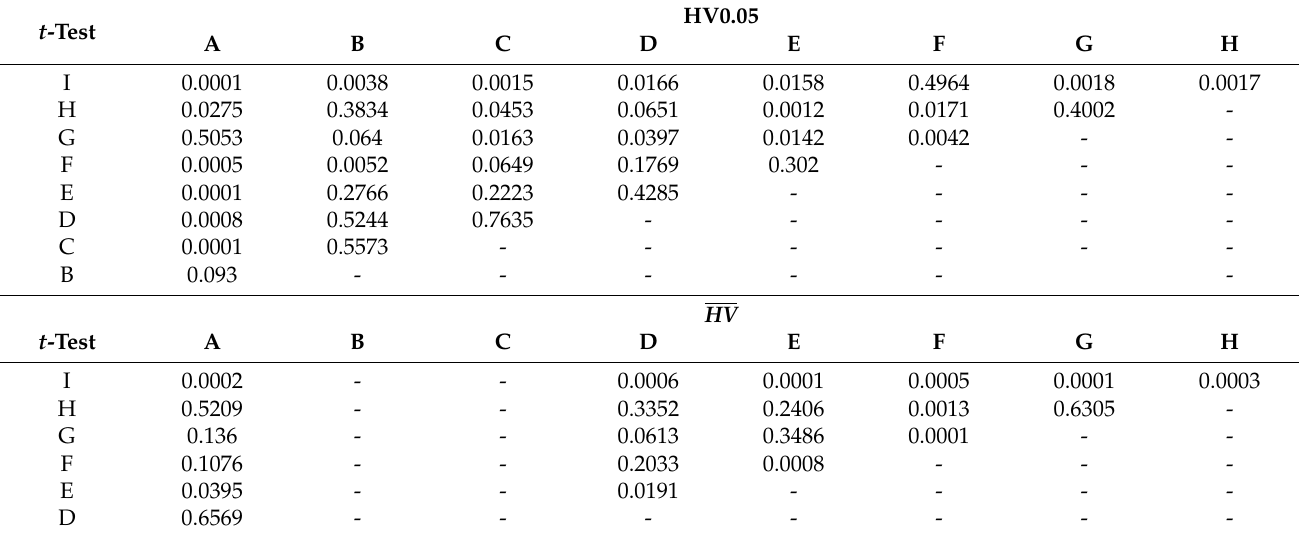
Table 4. The statistical significance of the micro-hardness measured in individual areas of sample ε 10 was obtained by t -test for the micro-hardness at all four loads HV and the load 0.49035 N (50 g).